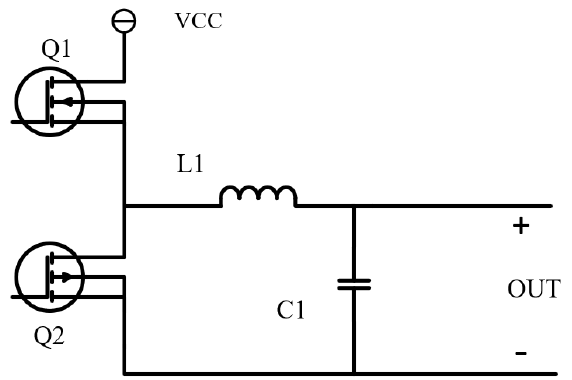
Figure 3. Synchronous rectification-type buck circuit structure diagram.